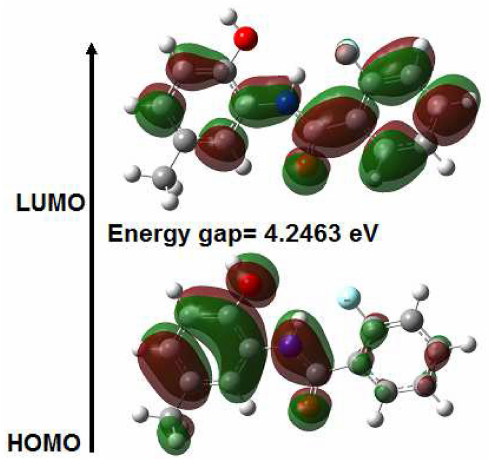
Figure 7. Electron distribution of the HOMO and the LUMO energy levels for o -FPhB